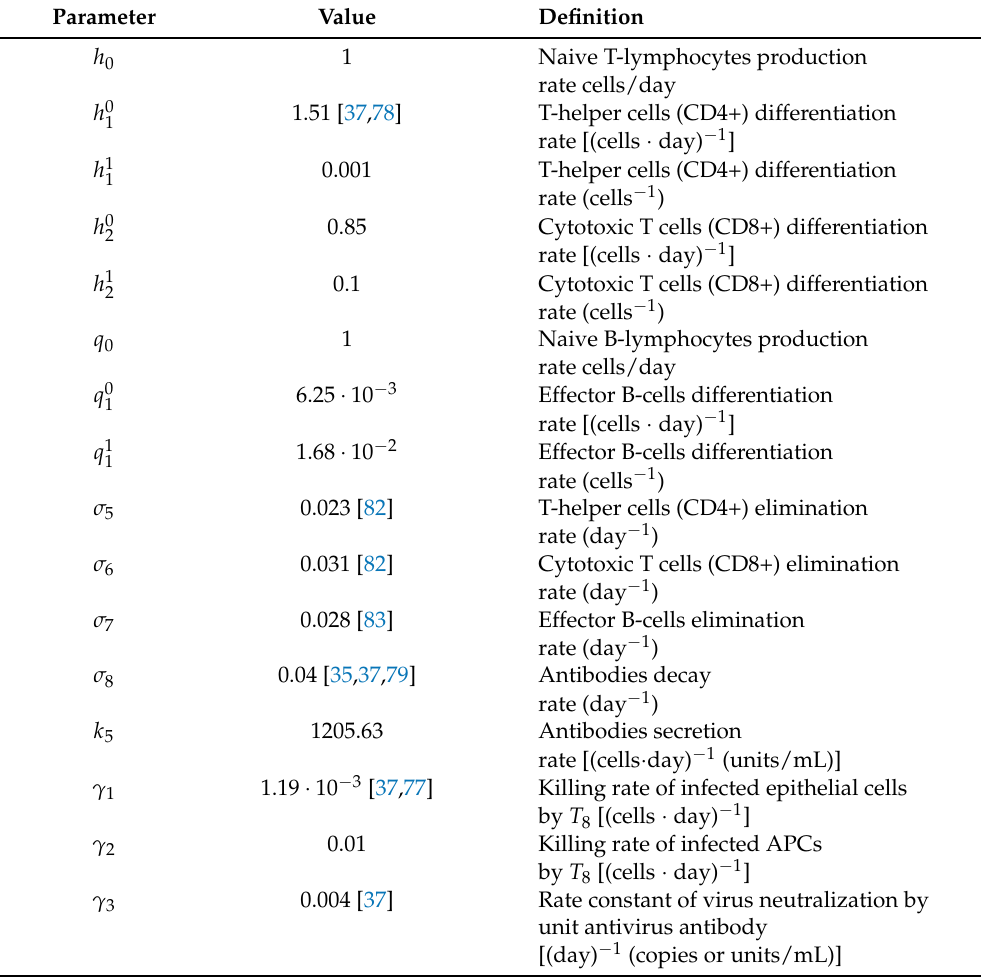
Table A2. Parameters for adaptive immune